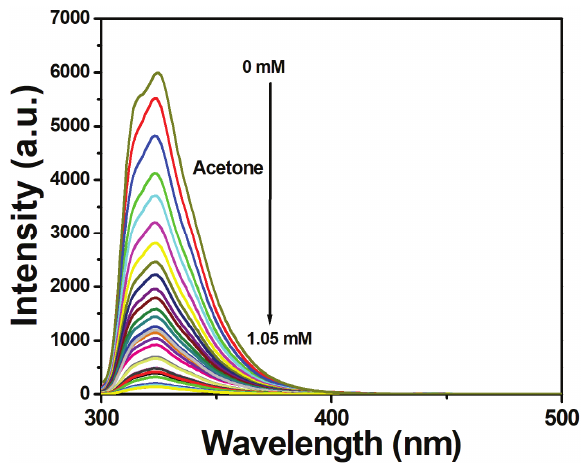
Figure 4. Changes in the fluorescence intensity of complex {[Zn(bipy) 2 (H 2 O)](ClO 4 ) 2 }( 1 ) upon titration with different concentrations of acetone (0–1.05 mM).